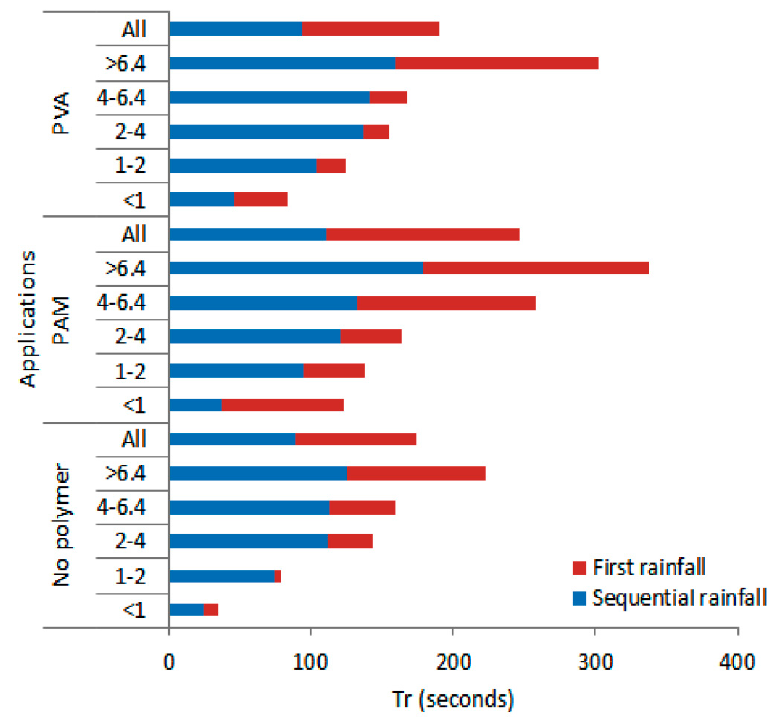
Figure 2. Time to runoff generation results per aggregate sizes. PAM: Polyacrylamide; PVA: Polyvinyl alcohol; Tr: Time to runoff.